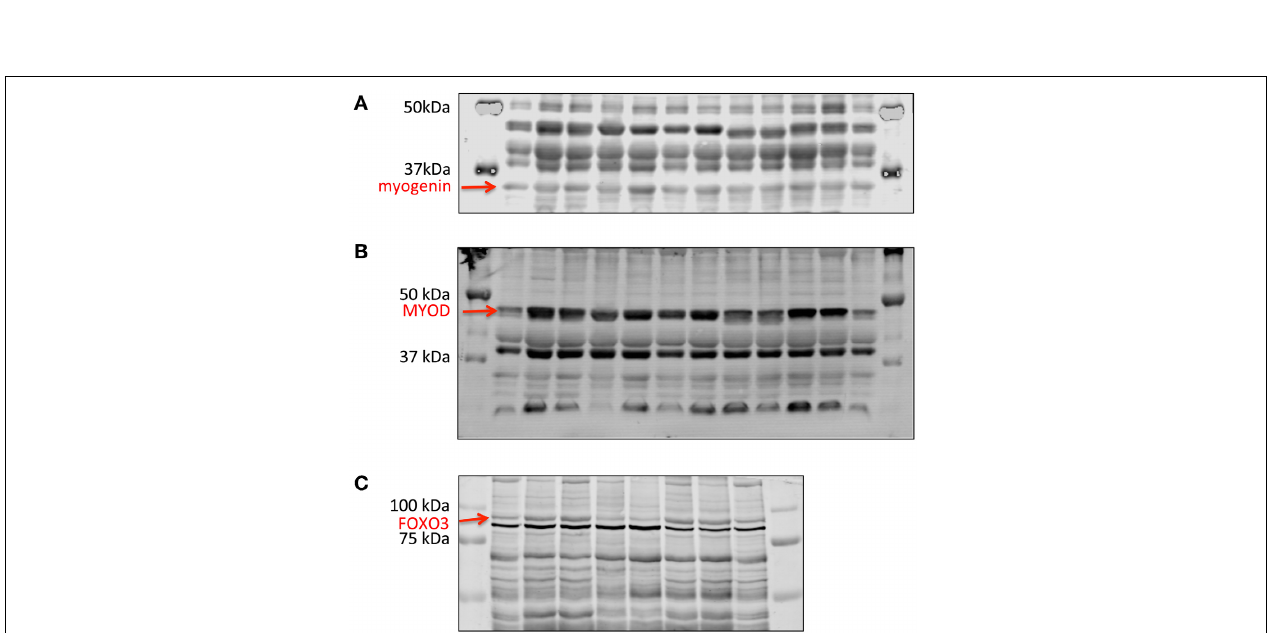
Frontiers in Physiology | Striated Muscle